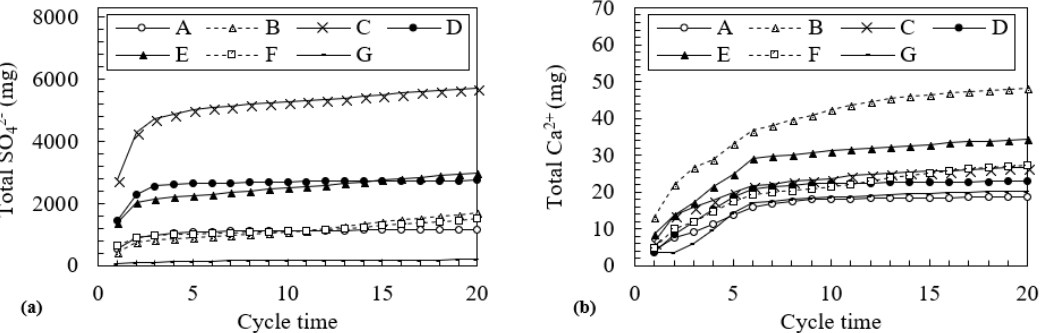
Figure 6. Integrated concentrations of dissolved ( a ) SO 42− and ( b ) Ca 2+ over 20 leaching cycles.